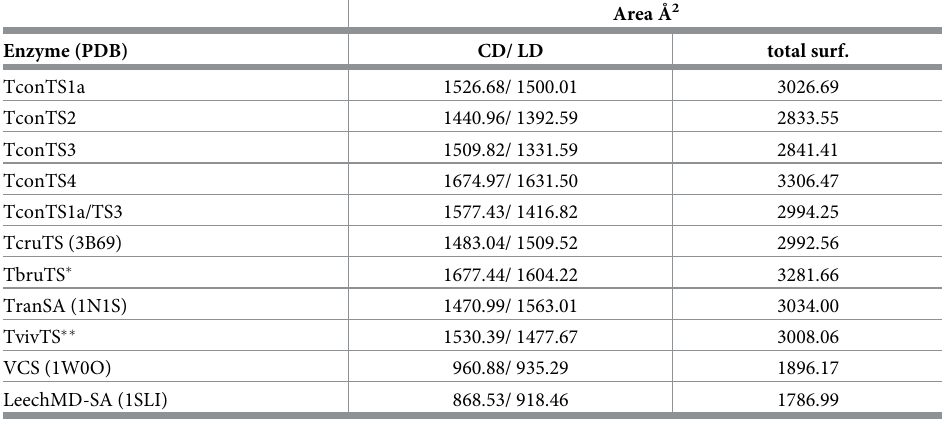
� Homology model for TbruTS was calculated using the amino acid sequence: EMBL AAG32055.1 �� Homology model for TvivTS was calculated using the amino acid sequence: EMBL